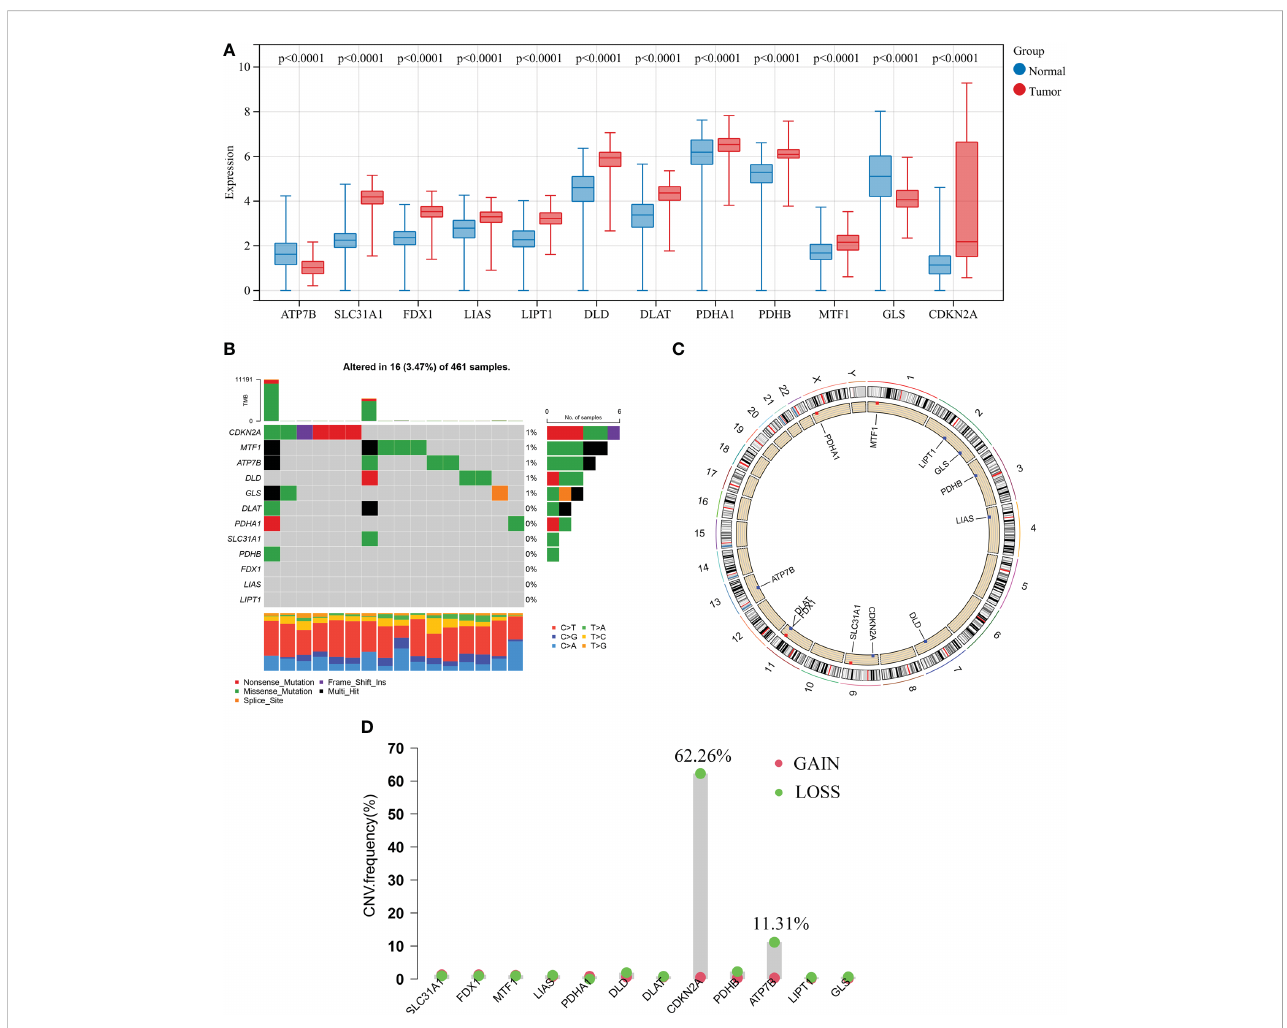
FIGURE 2 Transcriptional and genetic alterations of 12 CRGs in GBM. (A) Differentially expressed analyses of 12 CRGs between normal and GBM samples. (B) Mutation frequencies of 12 CRGs in 461 patients with GBM from the TCGA cohort. (C) Locations of CNV alterations in CRGs on 23 chromosomes. (D) Frequencies of CNV gain, loss, and non-CNV among CRGs. CRGs, cuproptosis-related genes; GBM, glioblastoma; TCGA, The Cancer Genome Atlas; CNV, copy number